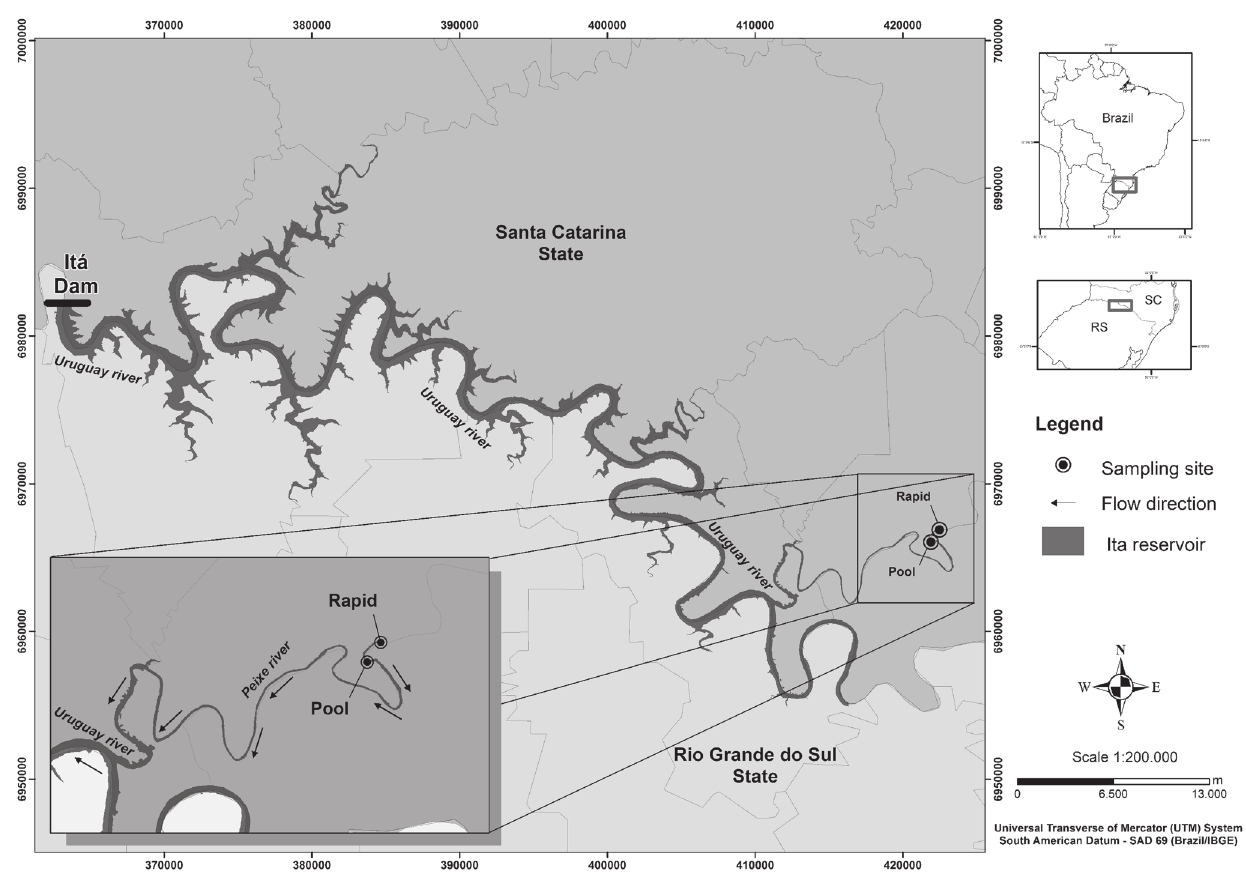
Fig. 1. Location of the sampling sites in the Peixe